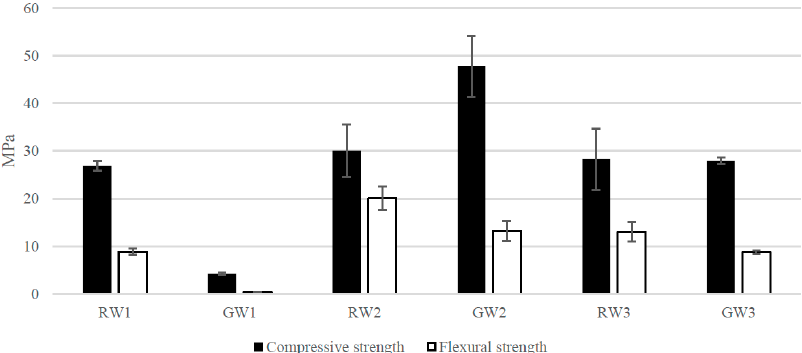
Figure 3. The compressive and flexural strength of each prepared sample. The bars show the average of at least three samples measured and the error represent the confidence interval for means at 95% confidence level.